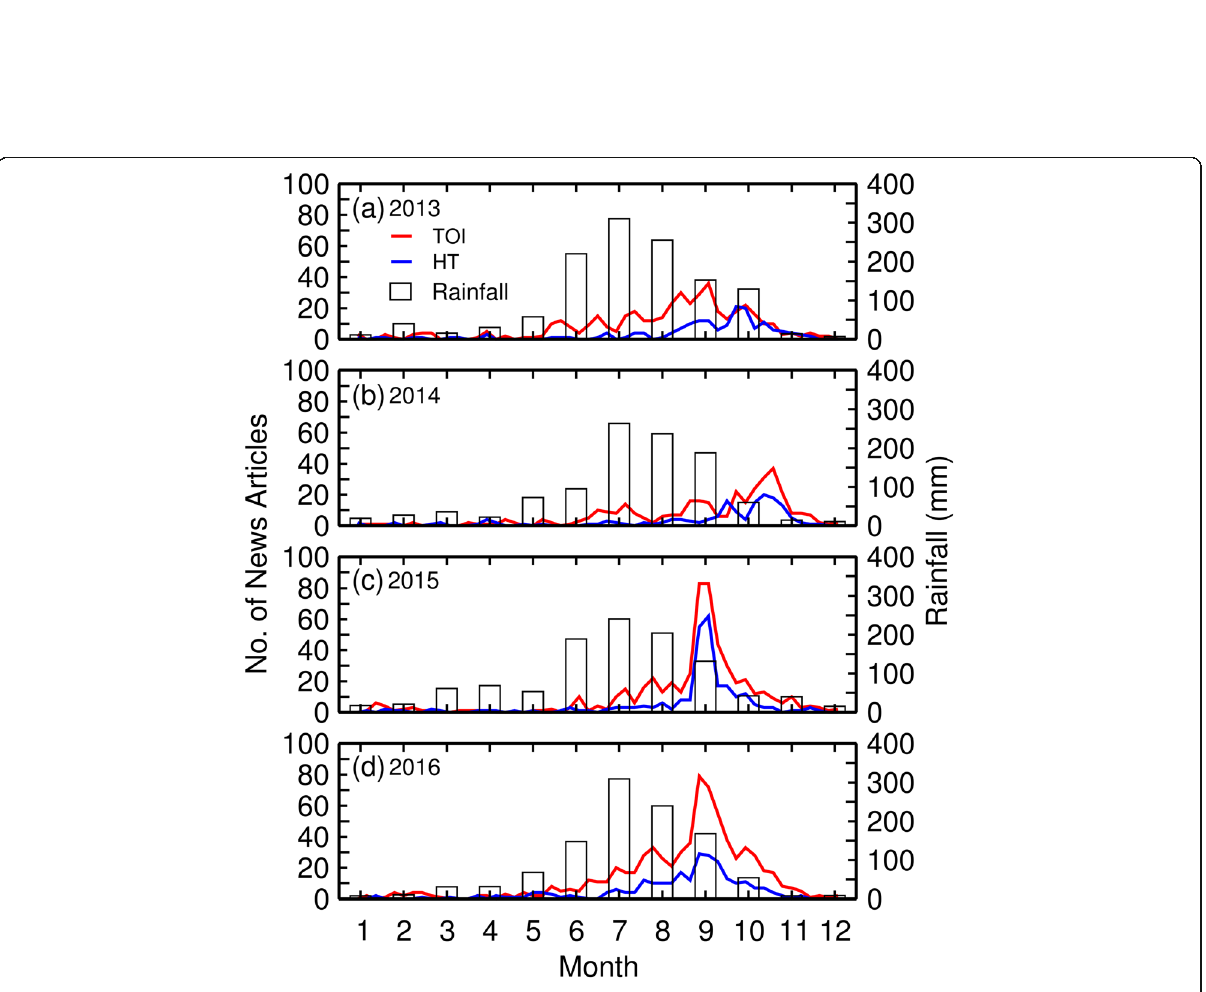
Fig. 2 The number of news articles on dengue fever published weekly in TOI and HT from 2013 to 2016 compared with the average monthly rainfall for